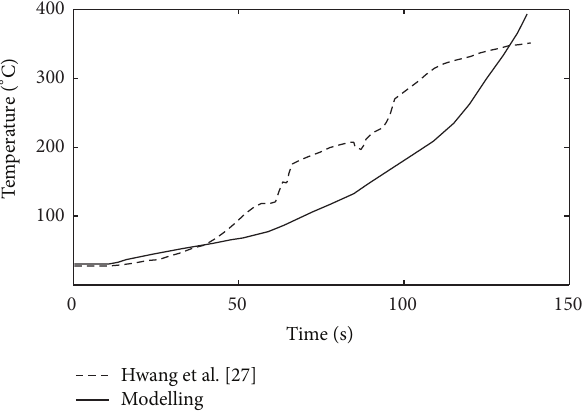
Figure3:Comparisonofthemodellingandexperimentalresultsfor the temperature during plunging and preheating.